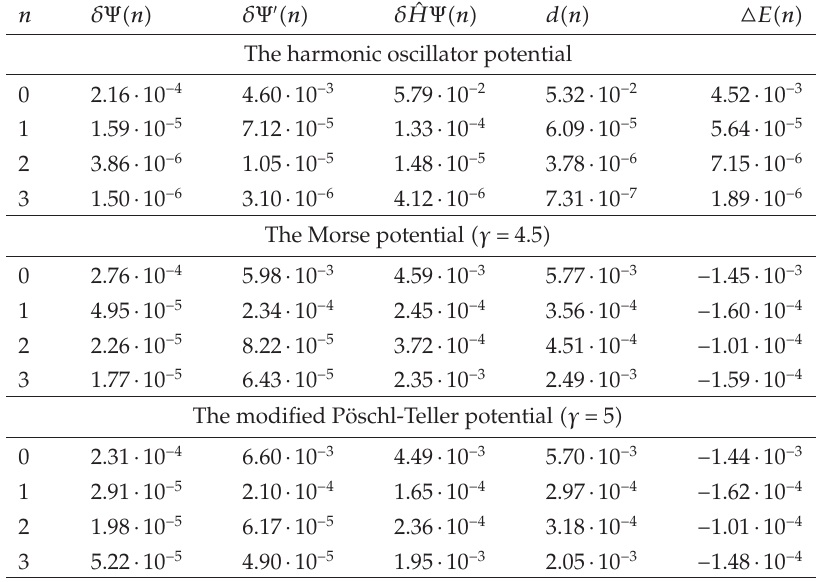
Table 4.1 . Numerical verification of the proposed